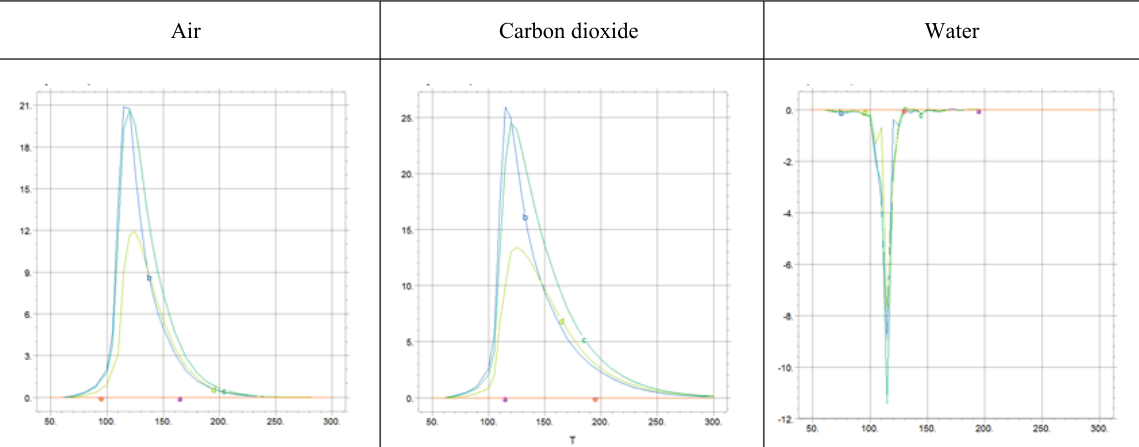
Table 2. Results of computation of the time course of temperature in the skeleton and the pore